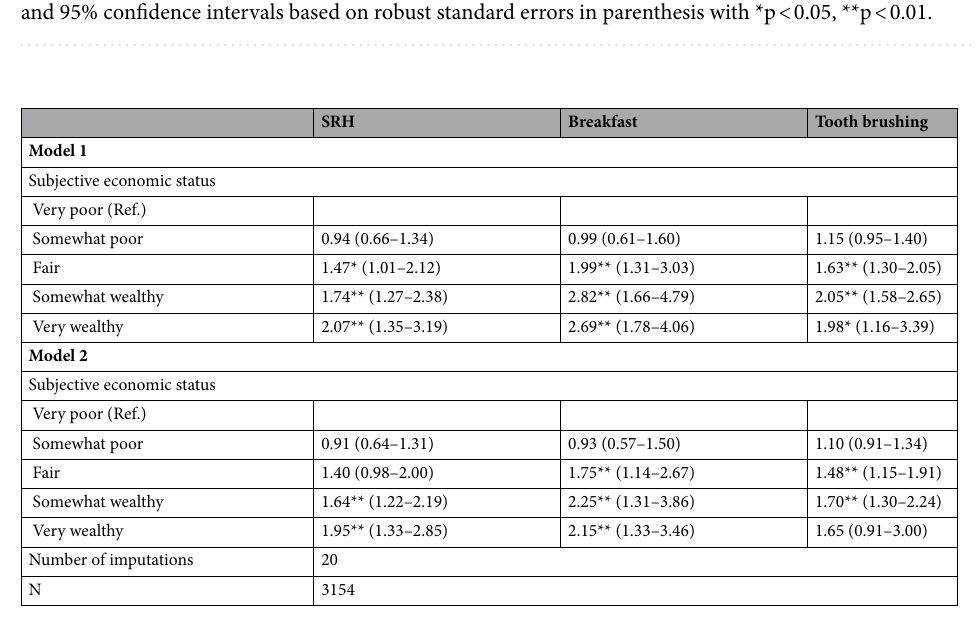
Table 7. Associations between subjective economic status and child health behaviours/health outcomes. These results were estimates by multilevel ordered logistic regression, controlling for sex of a child, parental ages, being in a single-parent household, and the scale of a residential area and fitting a three-level model incorporating school type nested within residential areas. Values are odds ratios and 95% confidence intervals based on robust standard errors in parenthesis with *p < 0.05, **p < 0.01. The bivariate associations of economic status assessed by children and child health outcomes with aforementioned controls were analysed in the model 1, while the model 2 adjusted for all three SES